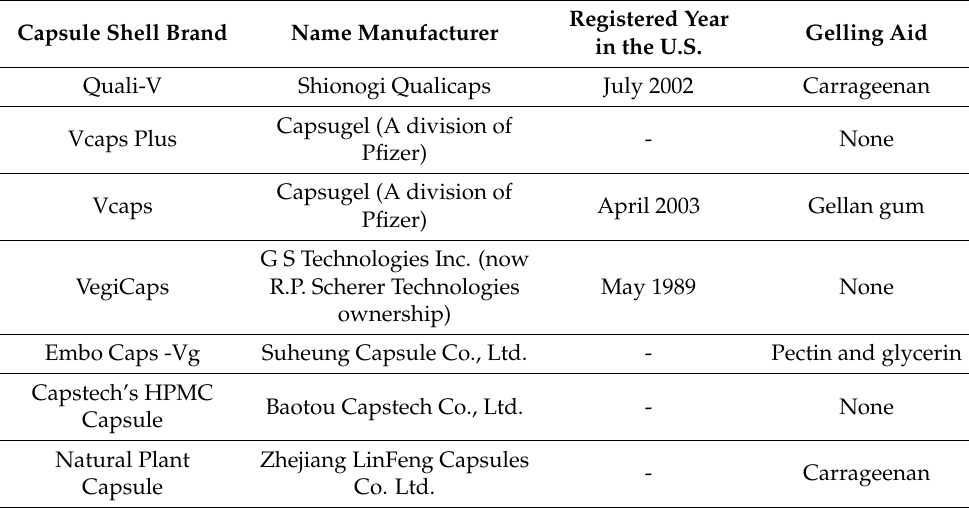
Table 4. Information on the empty HPMC capsules and their manufacturer, reprinted from [126], Canadian Society for Pharmaceutical Sciences